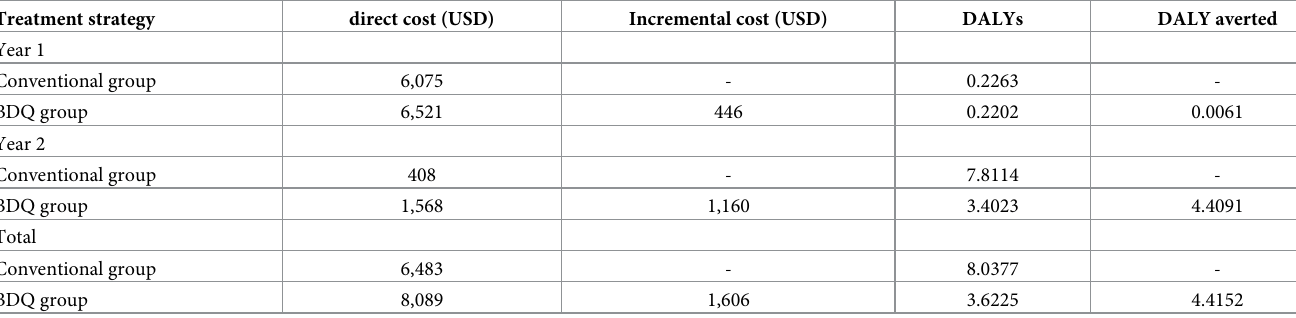
Table 2. Results of base-case